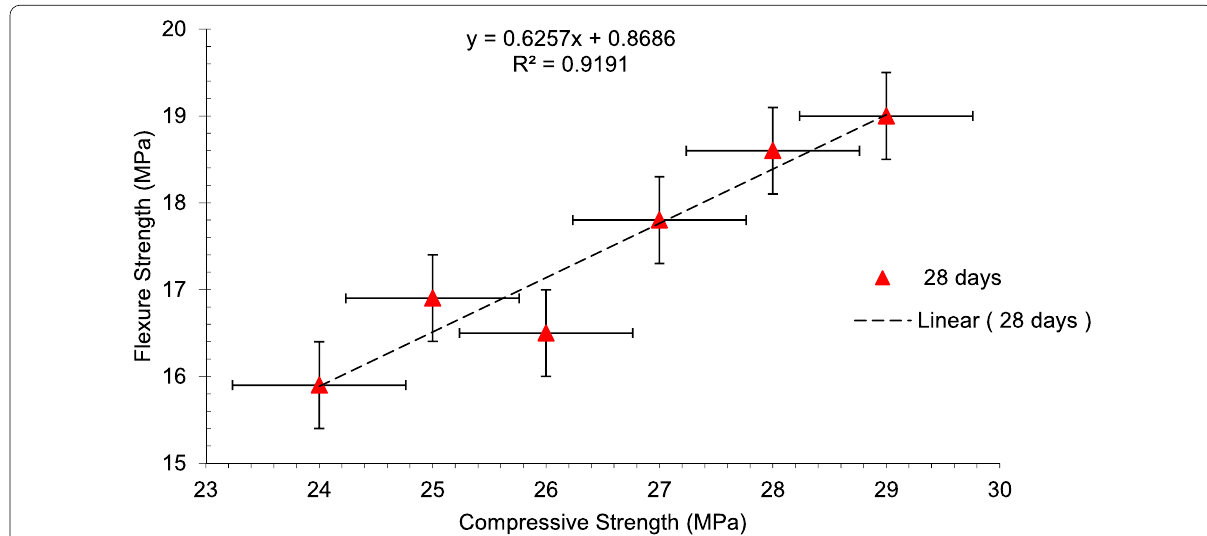
Fig. 18 Co‑relation flexure strength and compressive